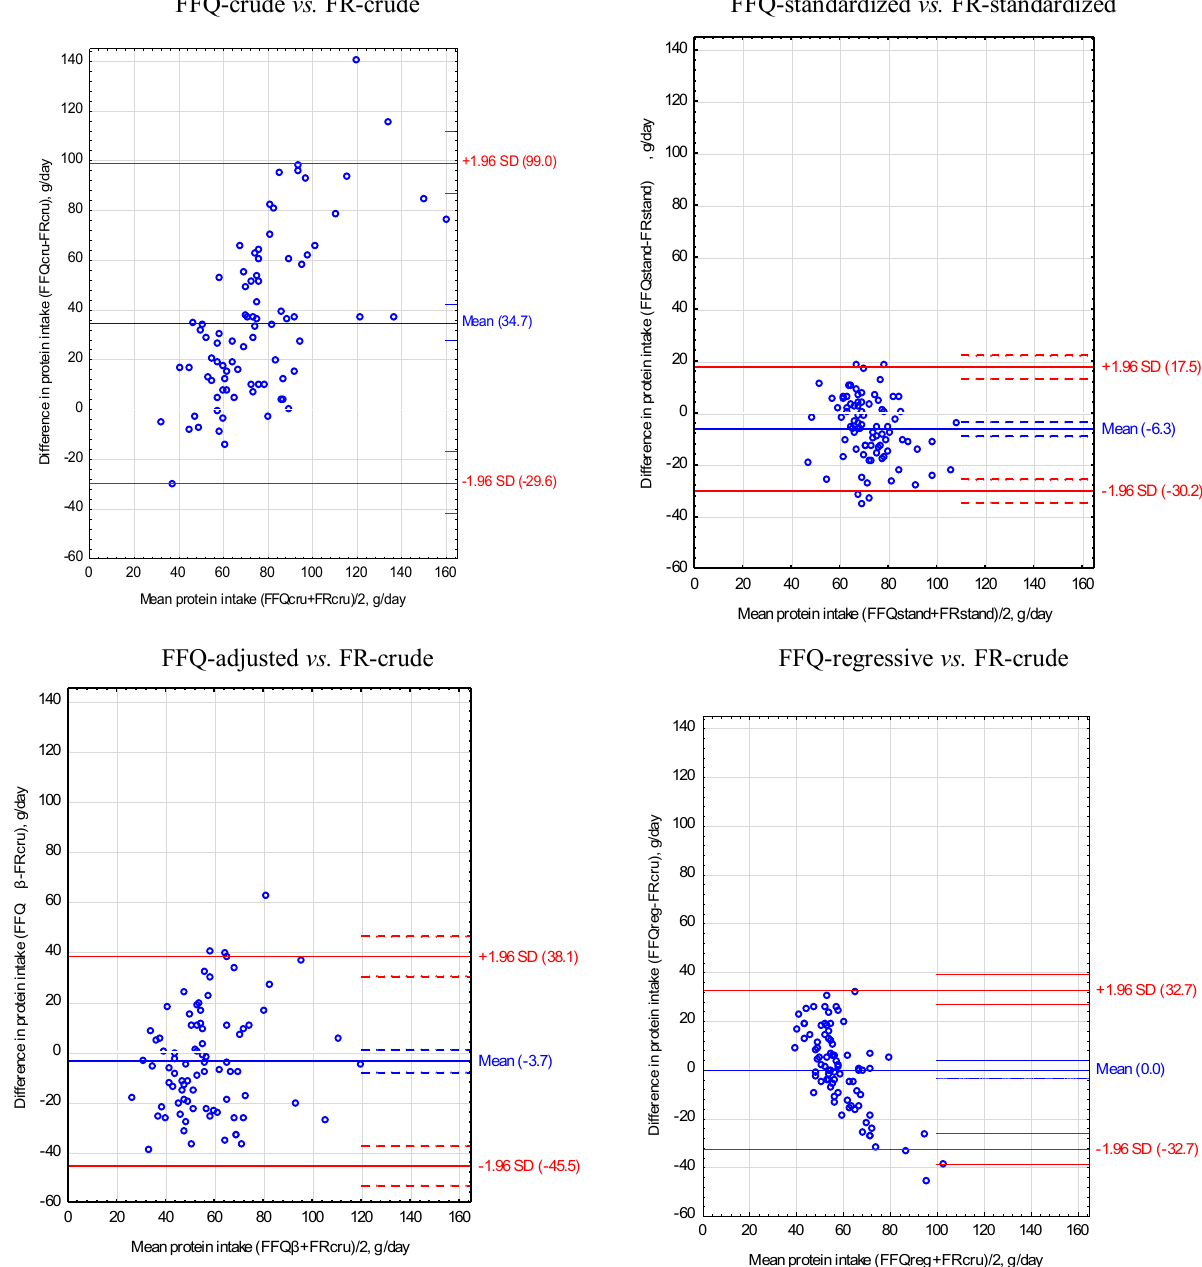
Figure 1. Bland-Altman plots to assess agreement between the food frequency questionnaire (FFQ) and three-day unweighted food record (FR) for protein intake in 84 women. FFQ-crude vs. FR-crude FFQ-standardized vs. FR-standardized